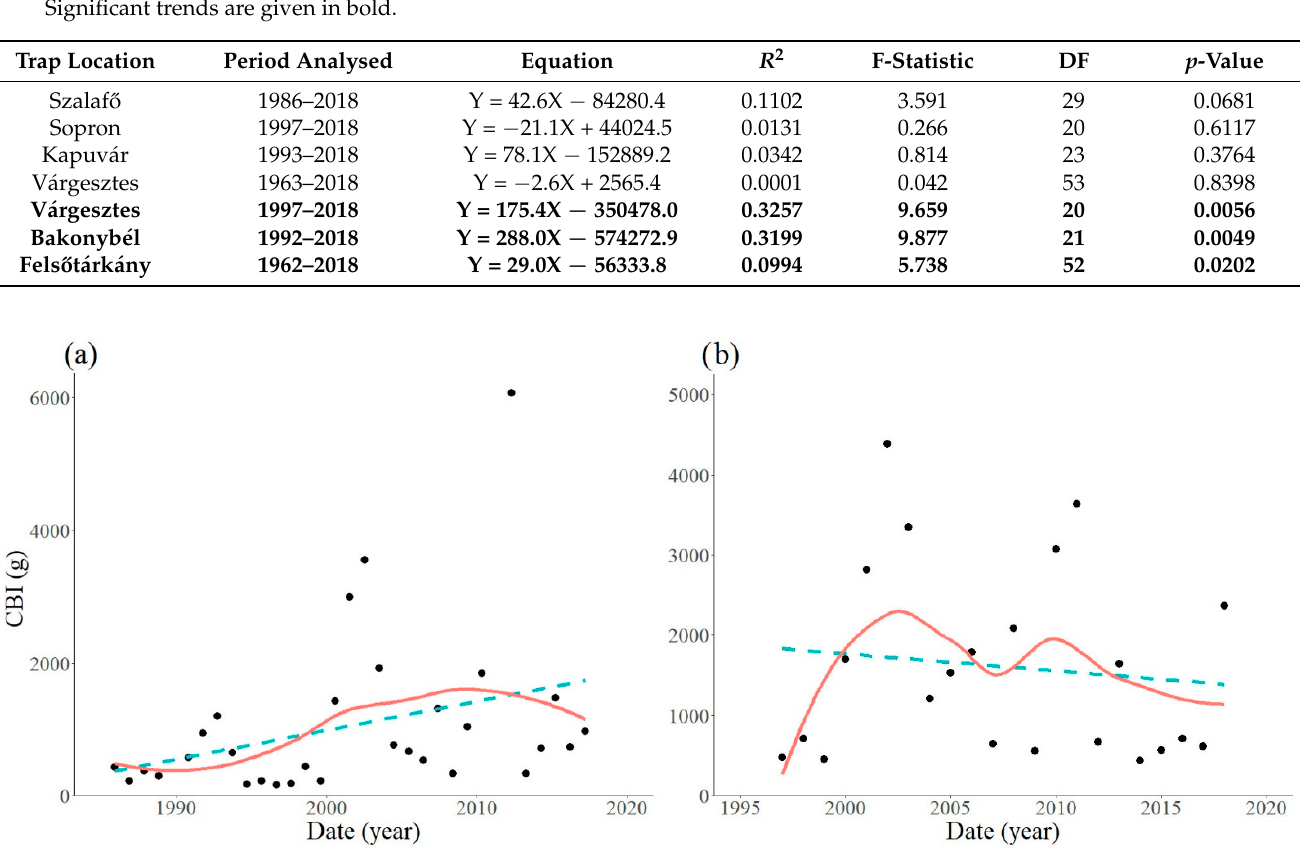
Figure 2. Yearly values and long term trends of the estimated spring caterpillar mass at Szalaf ő ( a ), and Sopron ( b ). (CBI, Caterpillar Biomass Index; blue dashed line, linear regression; red line, locally weighted regression with α = 0.8).